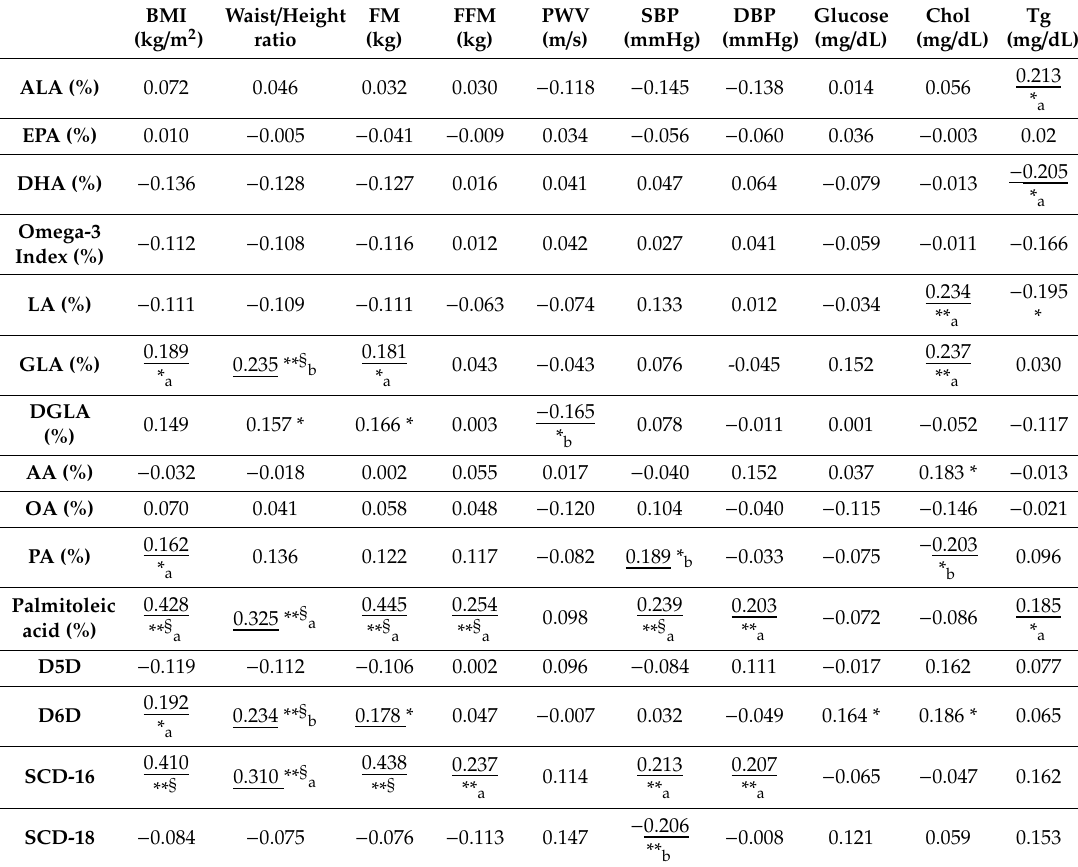
Table 5. Correlations of fatty acids and estimated desaturase activities with anthropometric and clinical parameters in Caucasian children (n: